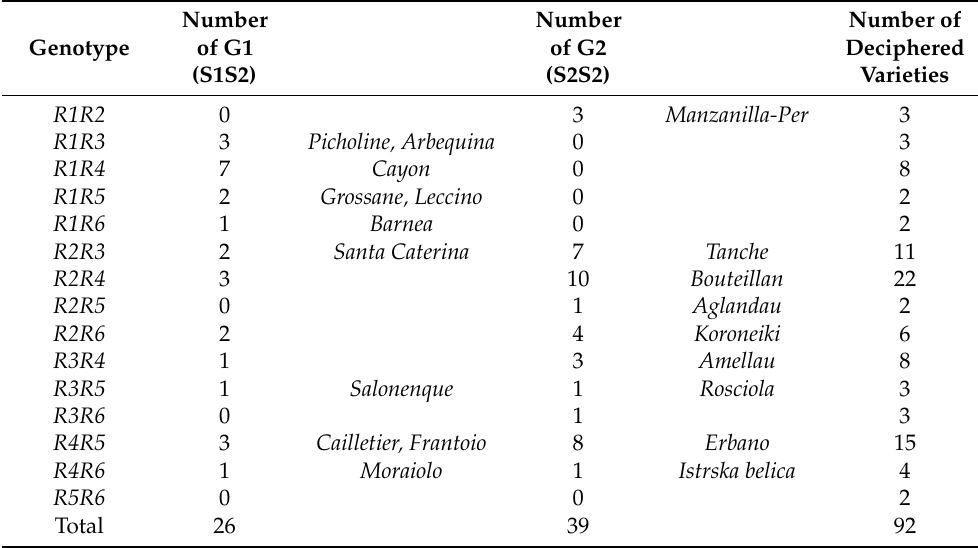
Figure 4. Diagrams showing the frequency of the nine pairs of genotypes in the PASI model and belonging to either a: G1 (S1S2), or b: G2 (S1S1) groups in the frame of the DSI model; raw data are given in Table 3. Table 5. Occurrence of S ‐ allele pairs from PASI in G1 and G2 groups, relative to the number of deciphered varieties from unpublished data.